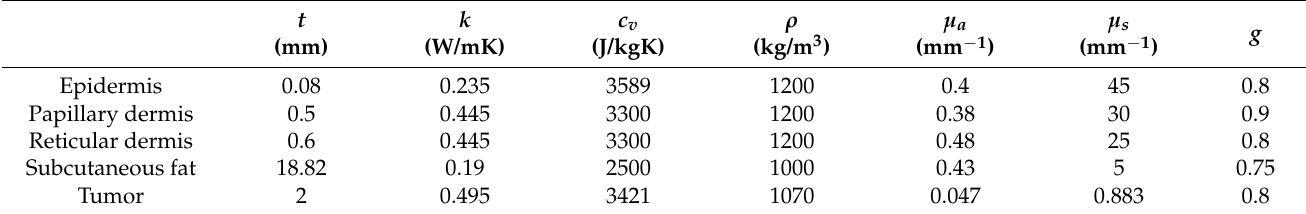
Figure 7. Schematic of the numerical simulation. Table 2. Properties of the skin layers and tumor [35–42].